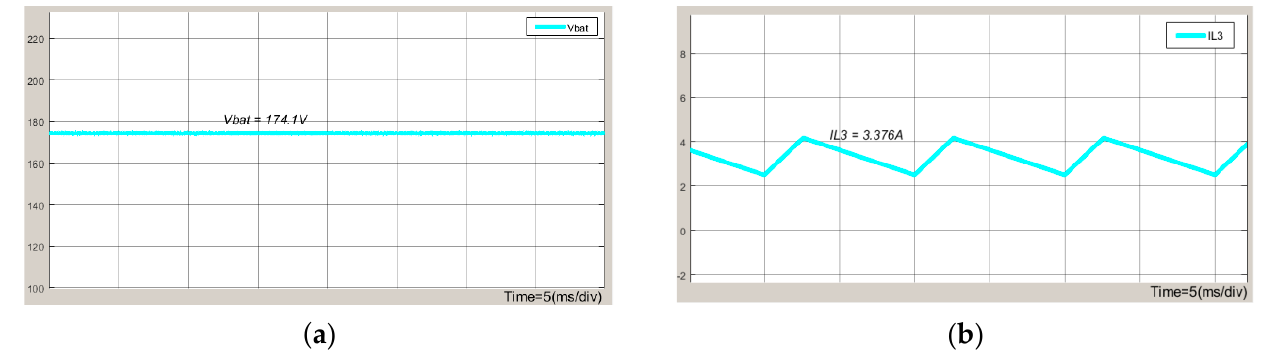
Figure 11. The simulation results of the operation of the load braking energy feedback: ( a ) the battery